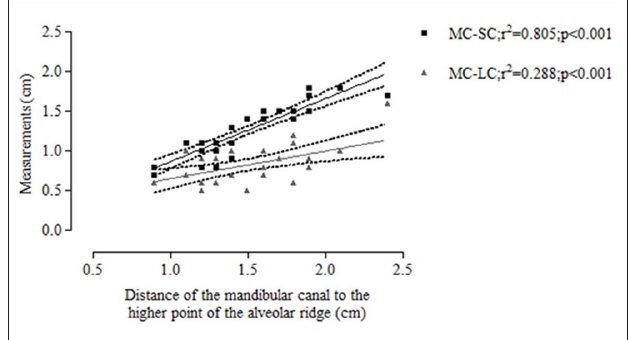
Fig. 7. Association between the distance from the highest point on the alveolar ridge and the distance from the mandibular canal to superior cortical (MC-SC) and the distance from the mandibular canal to lingual cortical